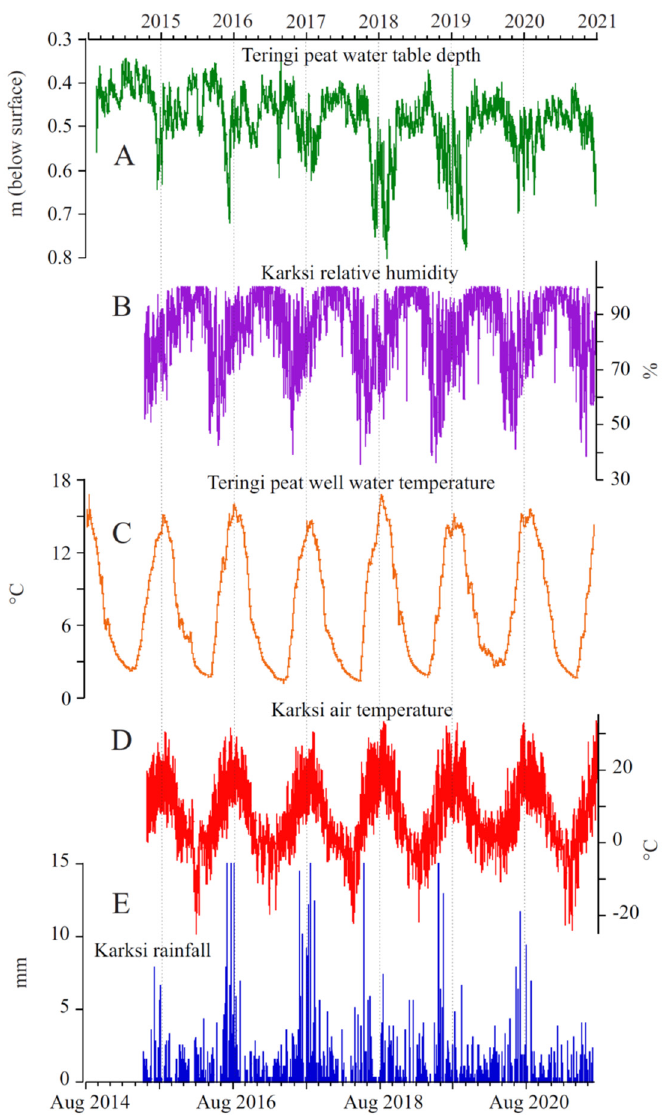
Figure 4. Automatic weather station from Karksi, Estonia ( B , D , E ) and levelogger data from Teringi Bog ( A , C ). The peat water temperature and water level were measured continuously from August, 2014 to July, 2021. The continuous automatic weather station measurements are from May, 2015 to July, 2021.